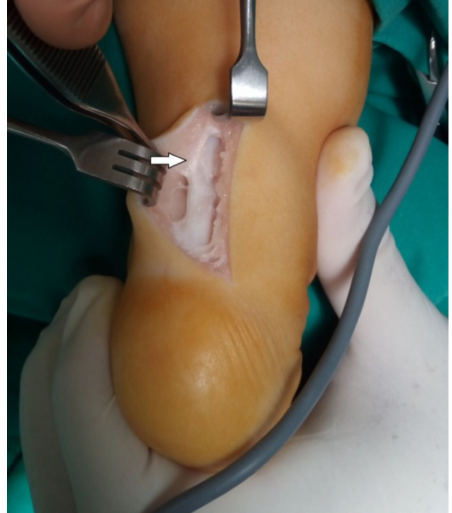
Figure 1. Arrow points to the adhesions of the thickened paratenon to the subcutaneous